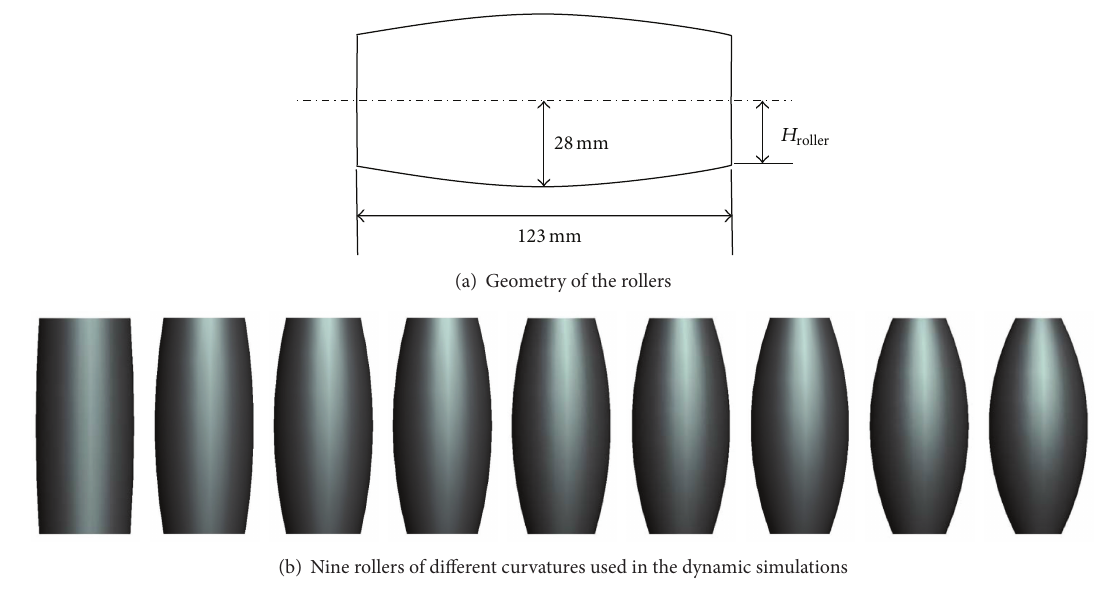
Figure 6: The geometry and shape of the rollers.